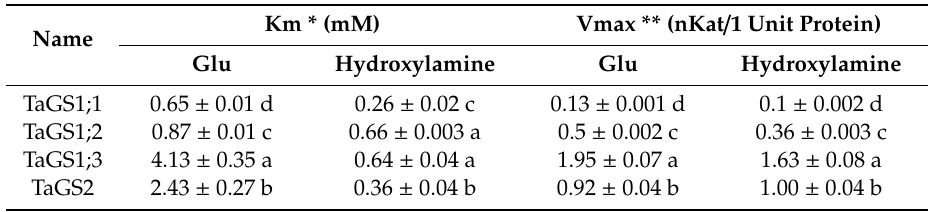
Figure 4. Kinetic properties of recombinant TaGS isozymes. Activity of individual recombinant wheat GS isozymes in relation to additional ( a ) glutamate (Glu), ( b ) hydroxylamine, and ( c ) glutamine (Gln). ( d ) TaGS1;2 activity was measured when Glu was supplied at concentrations of 0–5 mM. ( e ) TaGS1;2 activity was measured at different concentrations of hydroxylamine when Glu was supplied at 5 mM. Volume of individual recombinant wheat GS isozymes crude extract with 200 µ L of TaGS1;1, 150 µ L of TaGS1;2, 450 µ L of TaGS1;3, and 300 µ L TaGS2 was used for GS enzyme assays. ( f ) relative GS protein content of recombinant wheat GS isozyme crude extract. Upper panel shows TaGS immunoblot with same volumes of crude extract and lower panel shows relative content of recombinant TaGS protein in crude extract with same volume. Data represent means ± SE of at least three replicates. Table 1. Kinetic properties of wheat GS